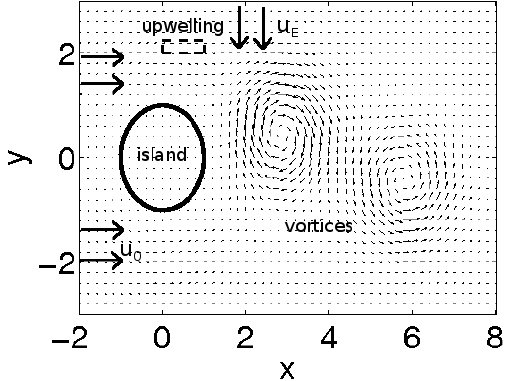
Fig. 1. A sketch of the observation region with the model velocity field (black arrows). The spatial coordinates are given in units of the island radius r = 25 km . The upwelling region is located at [0 , 1] × [2 , 2 . 25] . Two vortices with vortex strength ω can be seen in the island wake. The mean velocity field u 0 points in the positive x direction, while the Ekman flow u E , existing for x > 1 , points in the negative y-direction. stream function whose corresponding velocity field shows an astonishing qualitative agreement with the flow from direct numerical simulations of the Navier-Stokes equations. We use an extended version of this model flow including an Ekman drift perpendicular to the main flow introduced by 95 Sandulescu et al. (2006).